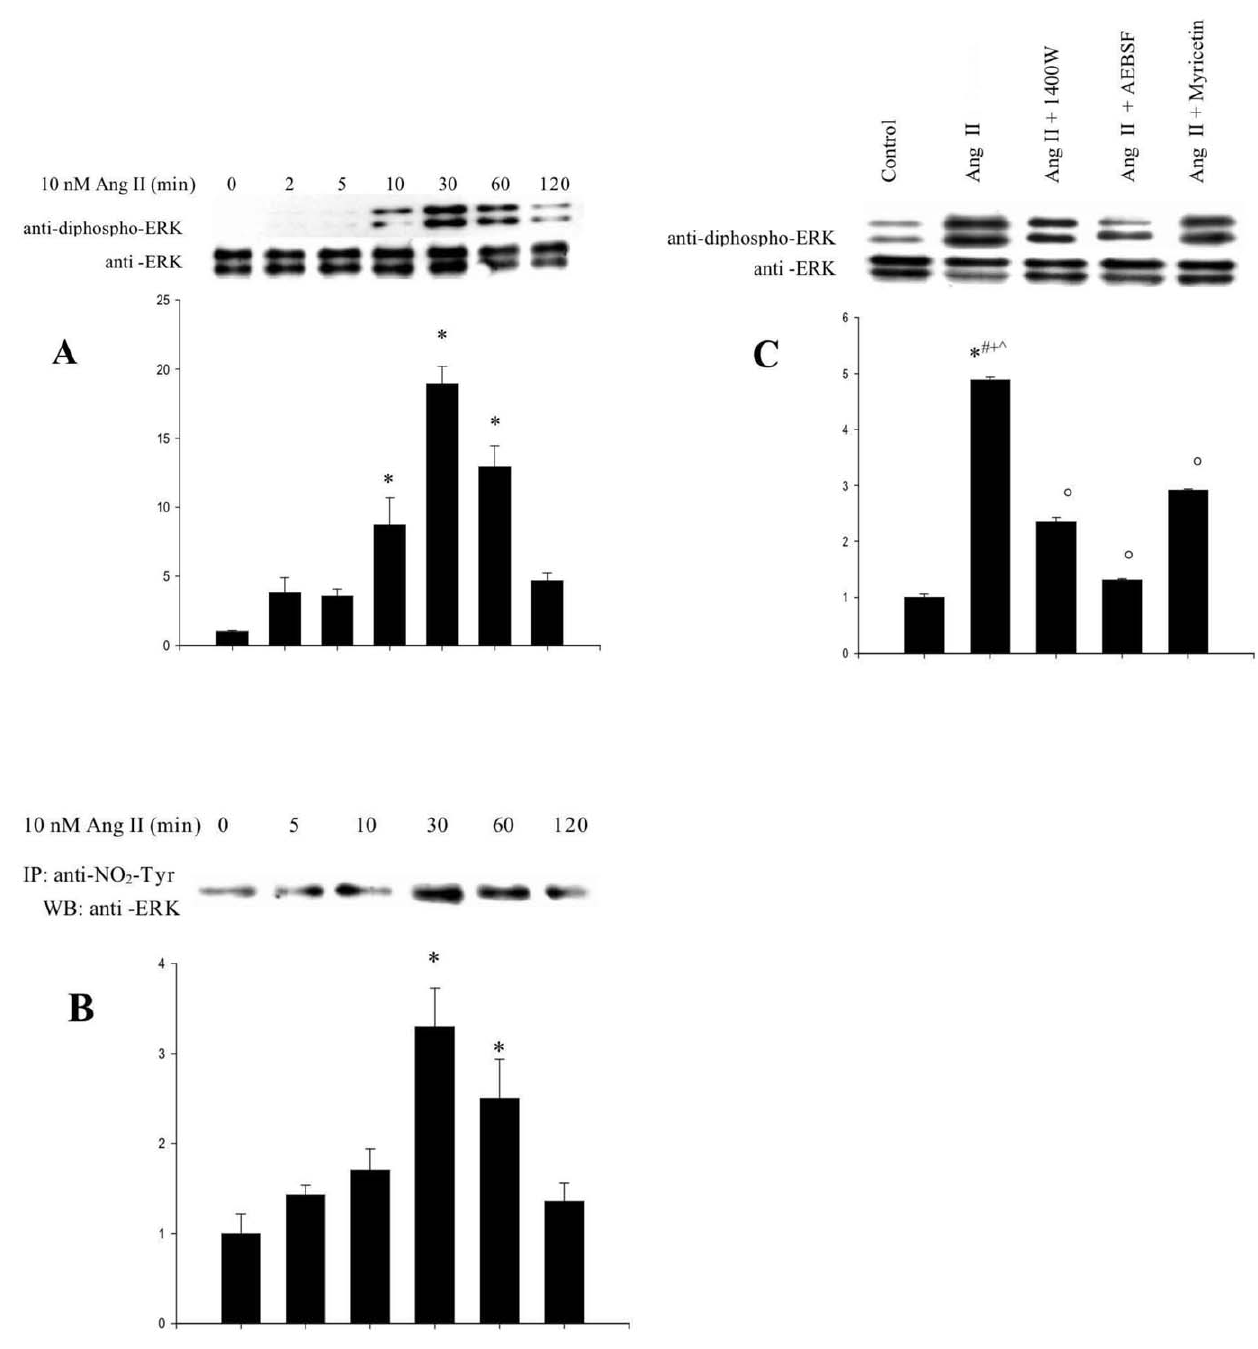
Figure 6. Kinetics of Ang II-dependent phosphorylation and nitration of ERK 1/2. L6 myotubes were exposed to Ang II (10 nM) for 0– 120 min. ( A ) Blots were probed with anti-phosphoERK1/2 and anti-ERK1/2 antibodies. ( B ) Samples were immunoprecipitated with anti-nitrotyrosine antibody and probed with anti-Akt antibody. ( C ) Effect of ROS and RNS modulators on ERK 1/2 phosphorylation. L6 myotubes were pretreated with either AEBSF (0.5 mM) for 30 min, 1400 W (10 m M) for 60 min or myricetin (100 m M) for 30 min, prior to addition of Ang II (10 nM) for 30 min and subsequent stimulation with insulin 100 nM for 60 min. Western blots were probed with anti-phosphoERK and anti-ERK antibodies. The blots are representative of three independent experiments. Results are expressed as the fold increase of the ratio of phospho-ERK/ERK over controls (means 6 s.d.) (* P , 0,05 vs control, u P , 0,05 vs Ang + Insulin, # P , 0,05 vs 1400 W + Ang, + P , 0,05 vs AEBSF + Ang, ‘ P , 0,05 vs Myricetine + Ang).